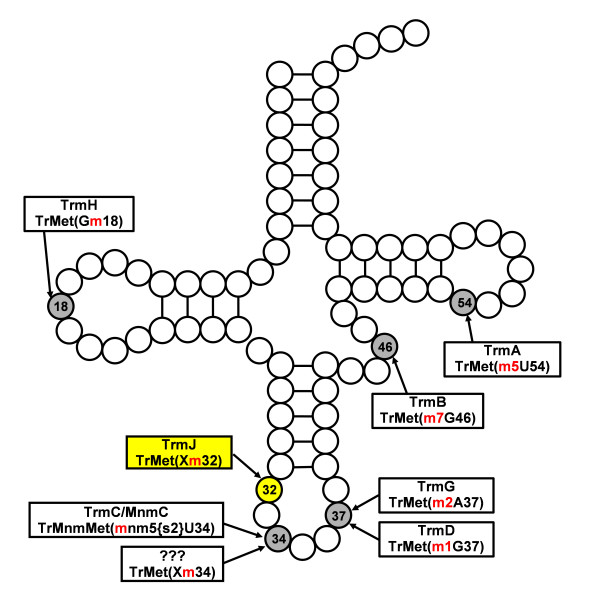
The cloverleaf representation of tRNAs from E. coli, with known methylated nucleosides and the respective enzymes indicated.